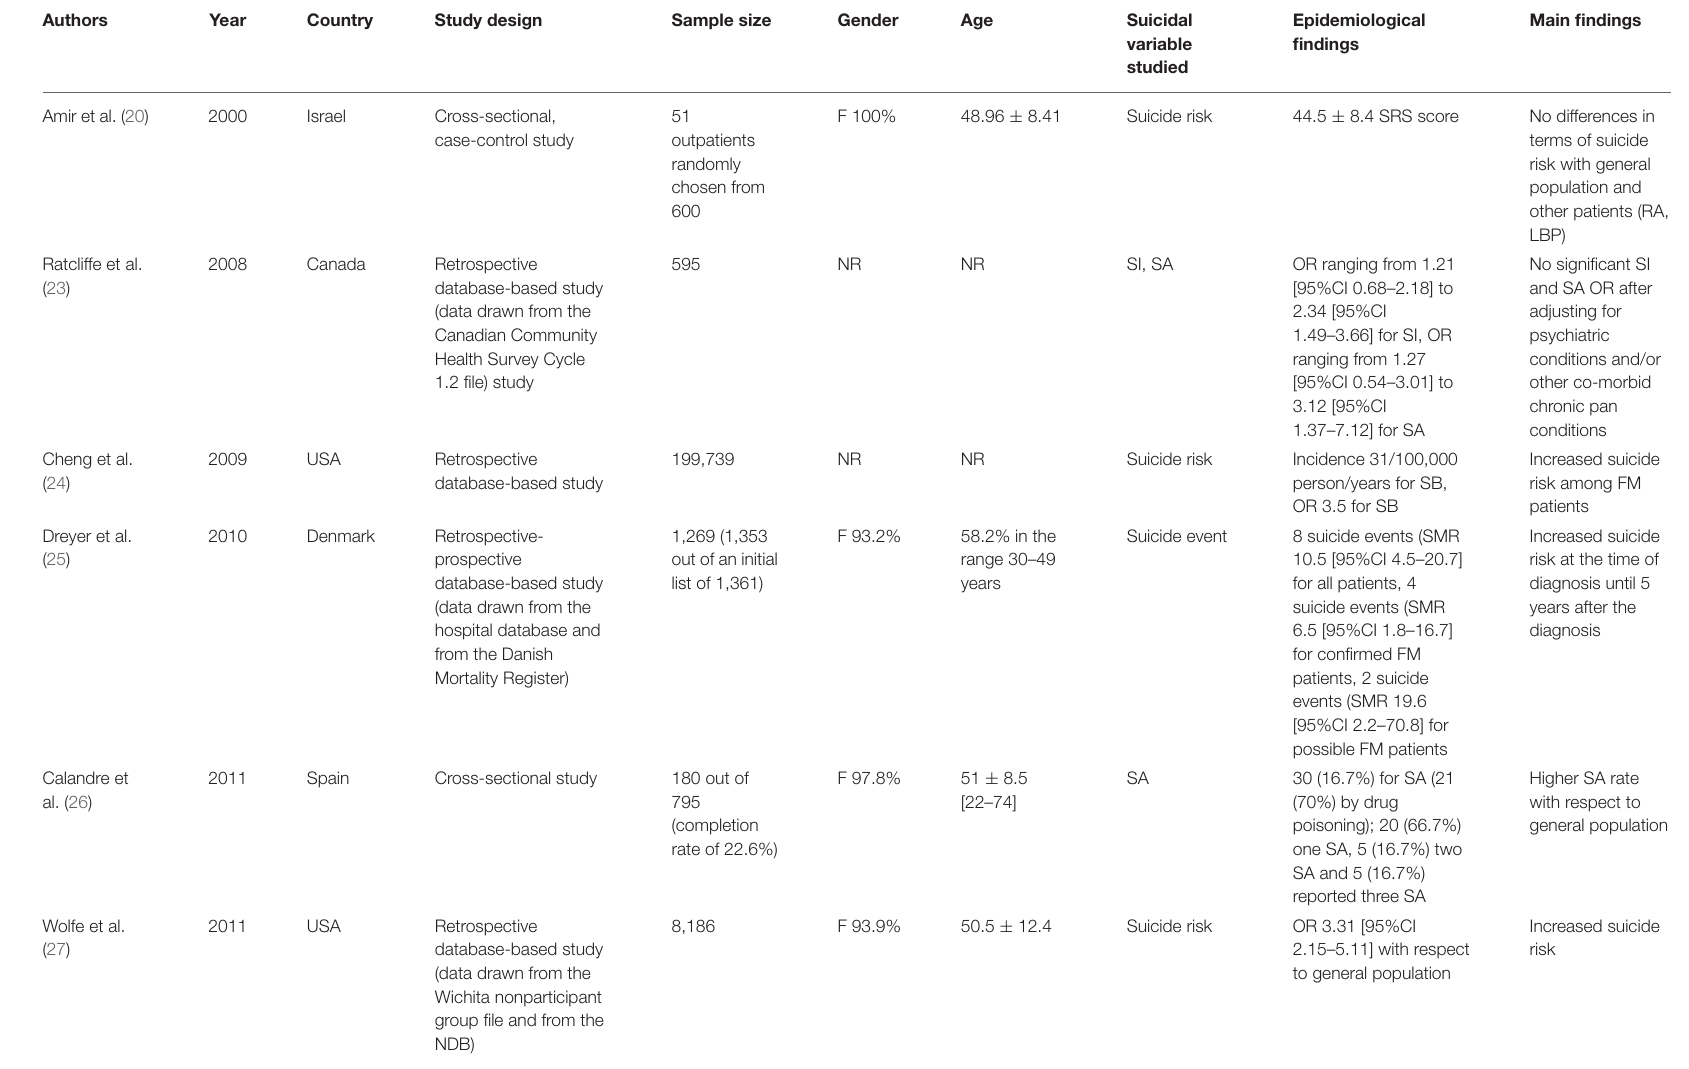
TABLE 2 | Main characteristics of included